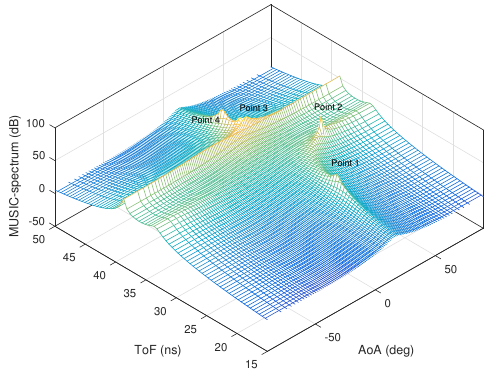
Figure 4. 2D Music spectrum with no noise.